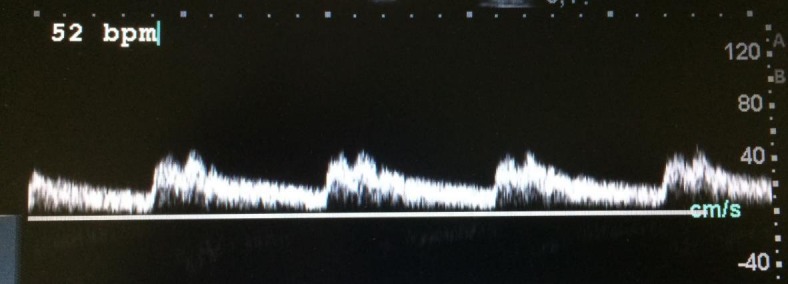
Pulsus bisferiens and bradycardia.